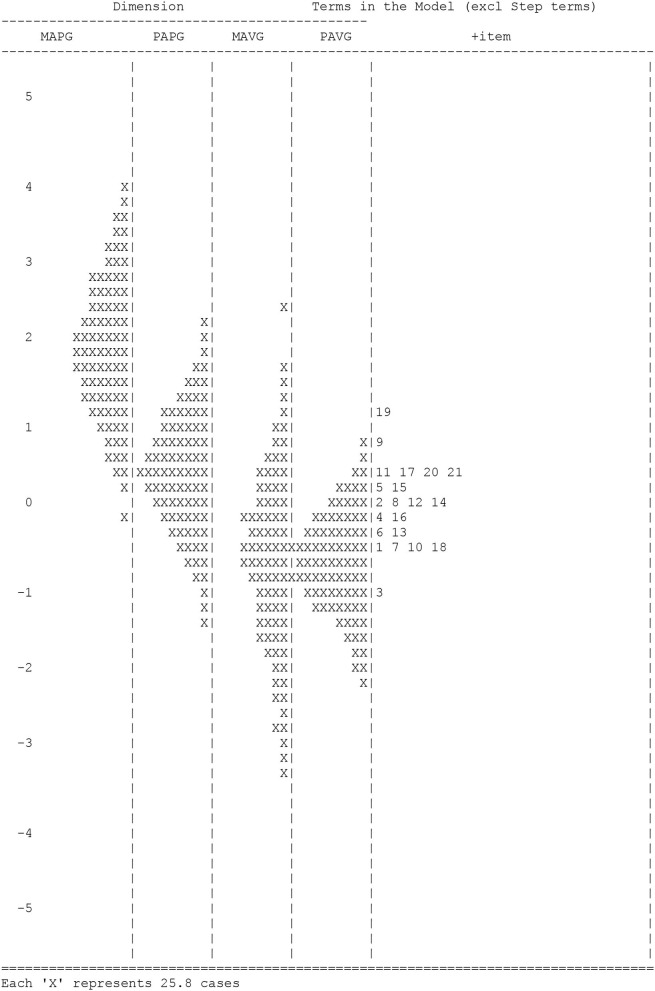
Item-person map.